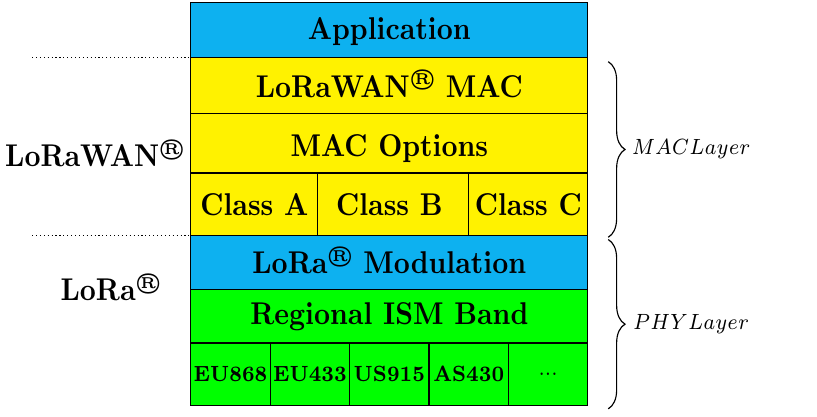
Figure 4. LoRaWAN protocol stack. Table 3. LoRaWAN Channel Plan based on Deployed Country/Region [123]. Country/Region Band/Channels (MHz) Channel Plan Europe 433.05–434.79, 863–870 EU433,